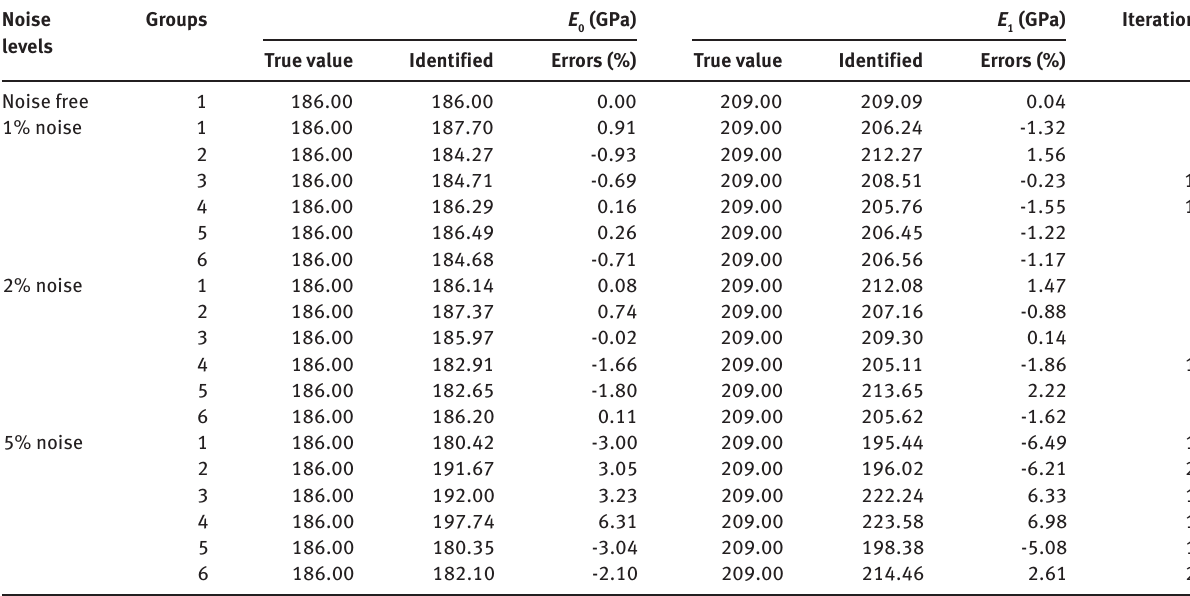
Table 12: Identified parameters of a rectangular FGM plane structure with exponential material variation (case 1: initial value E = 105 GPa). E 1